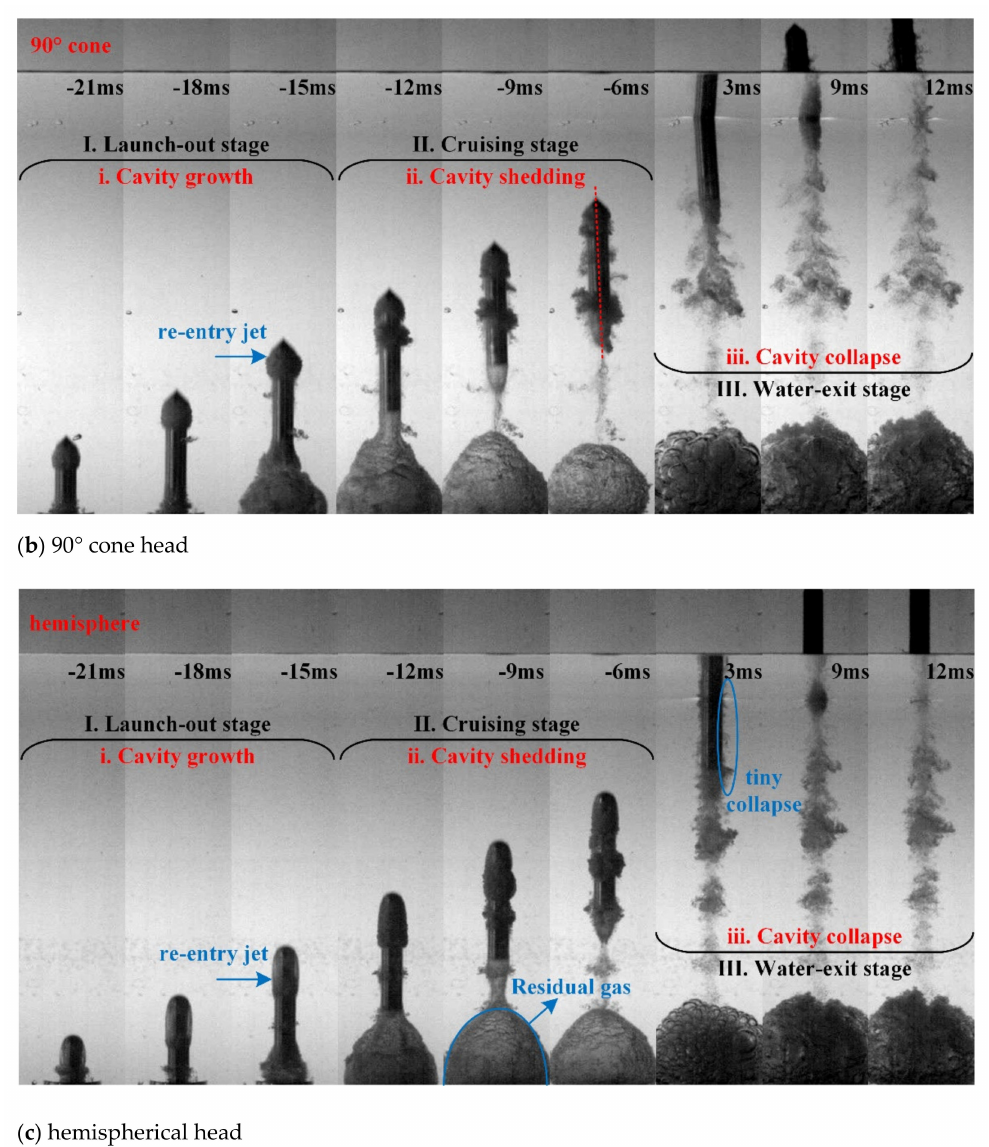
Figure 4. Unsteady cavitation evolution processes of three head-shaped projectiles. ( a ) 60 ◦ cone head ( b ) 90 ◦ cone head ( c ) hemispherical head. (I–III represent the projectile movement process, i–iii represent the cavitation evolution process).